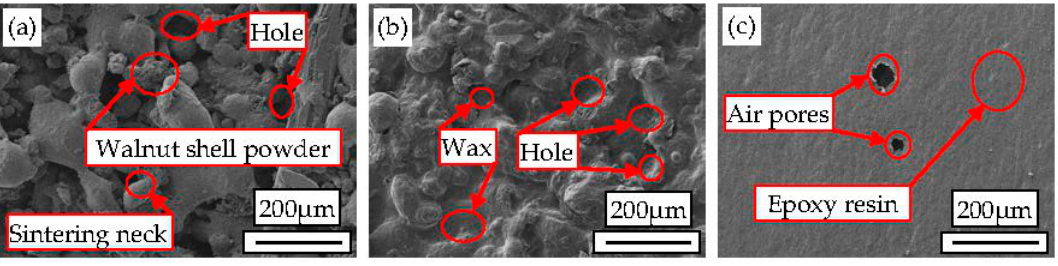
Figure 8. The surface morphology of WSPC parts and after-treatment parts (40% walnut shell powder): ( a ) sintered parts; ( b ) wax-permeated parts; and ( c ) resin-permeated parts.